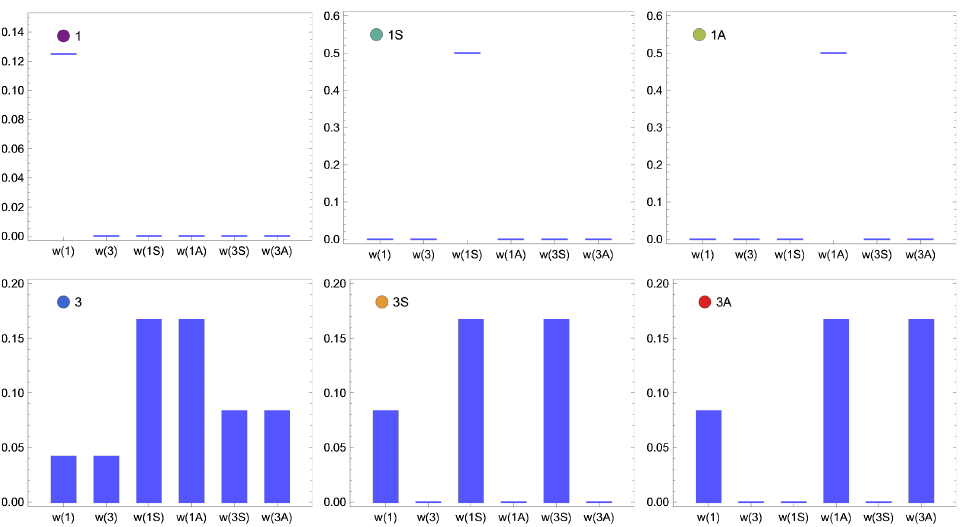
Figure 12. Solutions for w α (denoted as w ( α )) at all generators, ~g 1 ,~g 1 S ,~g 1 A ,~g 3 ,~g 3 S ,~g 3 A . The blue bar indicates the allowed range of w